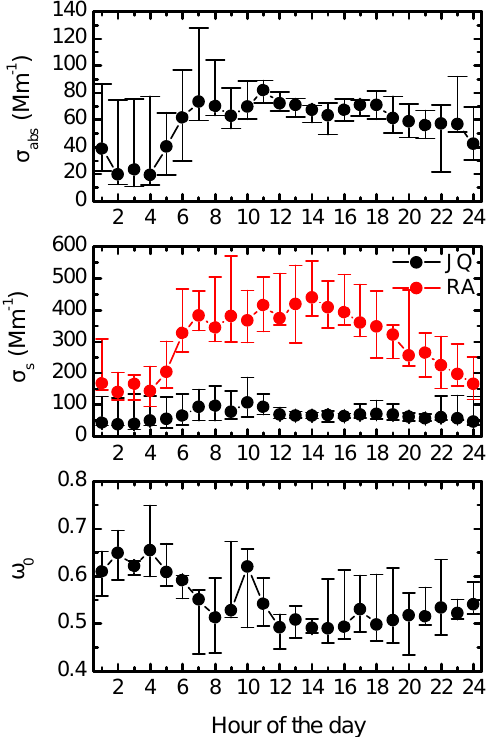
Fig. 10. Median values for (top) light absorption, (middle) light scattering and (bottom) single scattering albedo. The range bars rep- resent the 10th and 90th